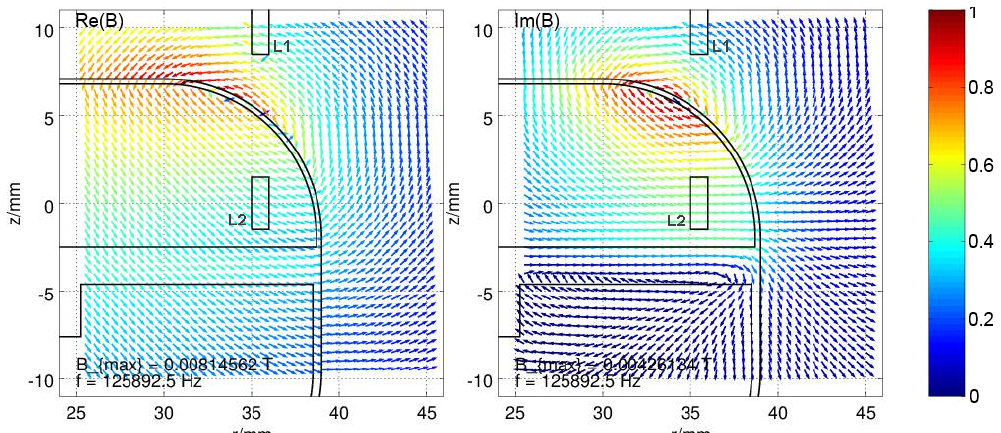
Figure 9. Resulting magnetic field vector distribution, caused by eddy currents in the housing, while exciting L 1 , split into real part (Re(B)) and imaginary part (Im(B)) of the field. The field strength is normalized to the maximum field strength B max and shown by the color, according to the colorbar.